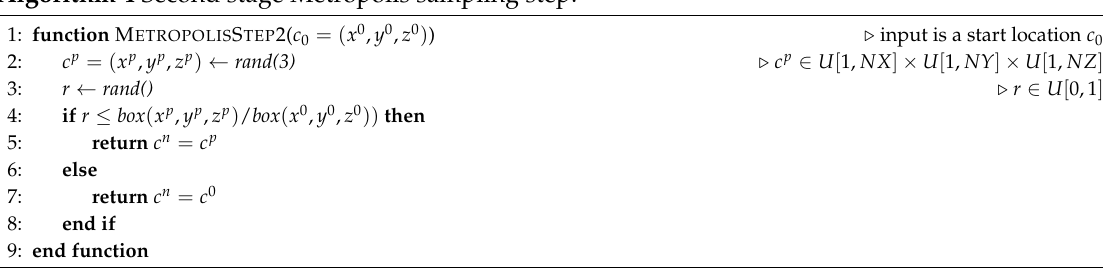
Algorithm 4 Second stage Metropolis sampling step.